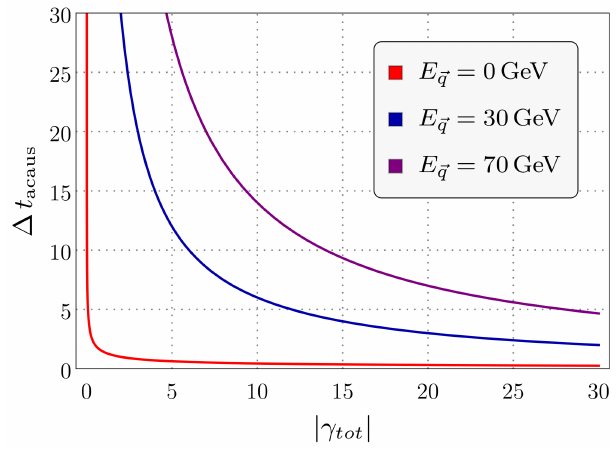
Figure 11 . Time scale of acausality ∆ t acaus (measured in GeV − 1 ) in the presence of a complex poles q 2 = E 2 − iγ tot as a function of | γ tot | (in units of GeV 2 ) for various energies E ~q 0 , pole ~q